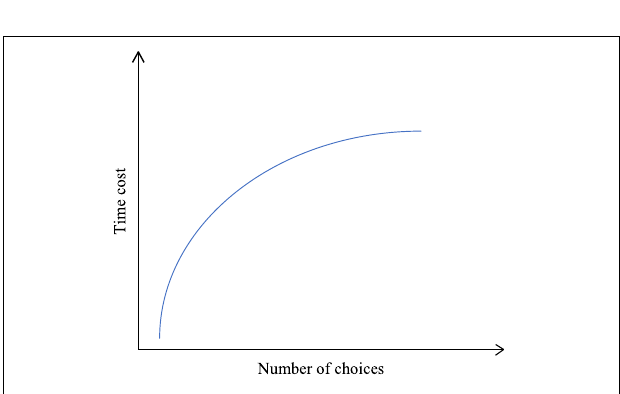
FIGURE 2 | Schematic diagram of the relationship between the time cost and the number of